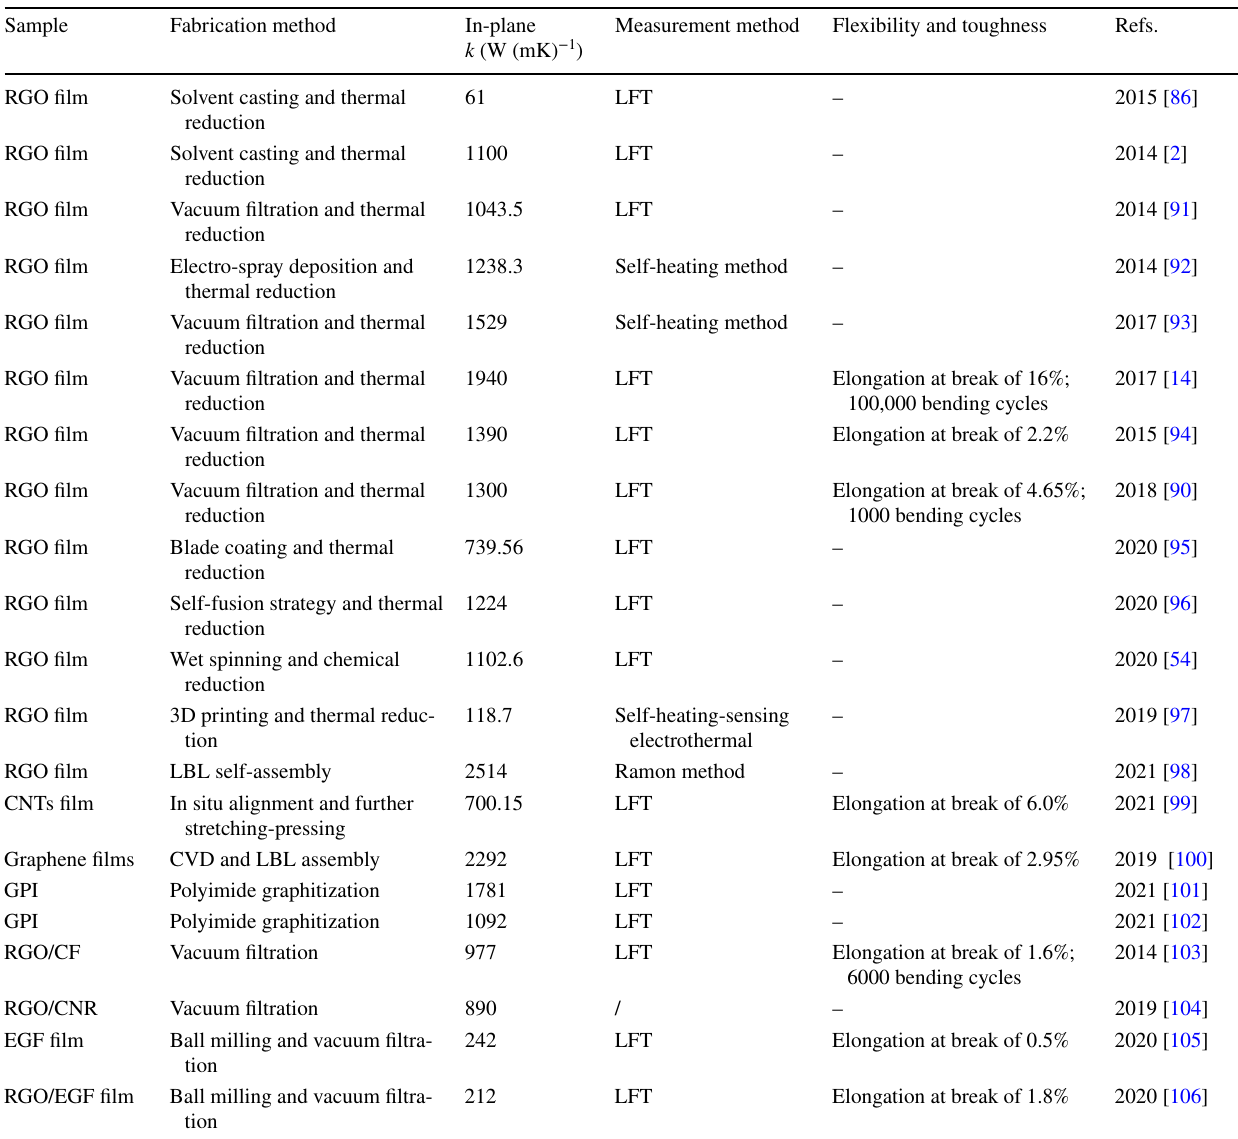
Table 3 The summary of thermally conductive all‑carbon films with high in‑plane k